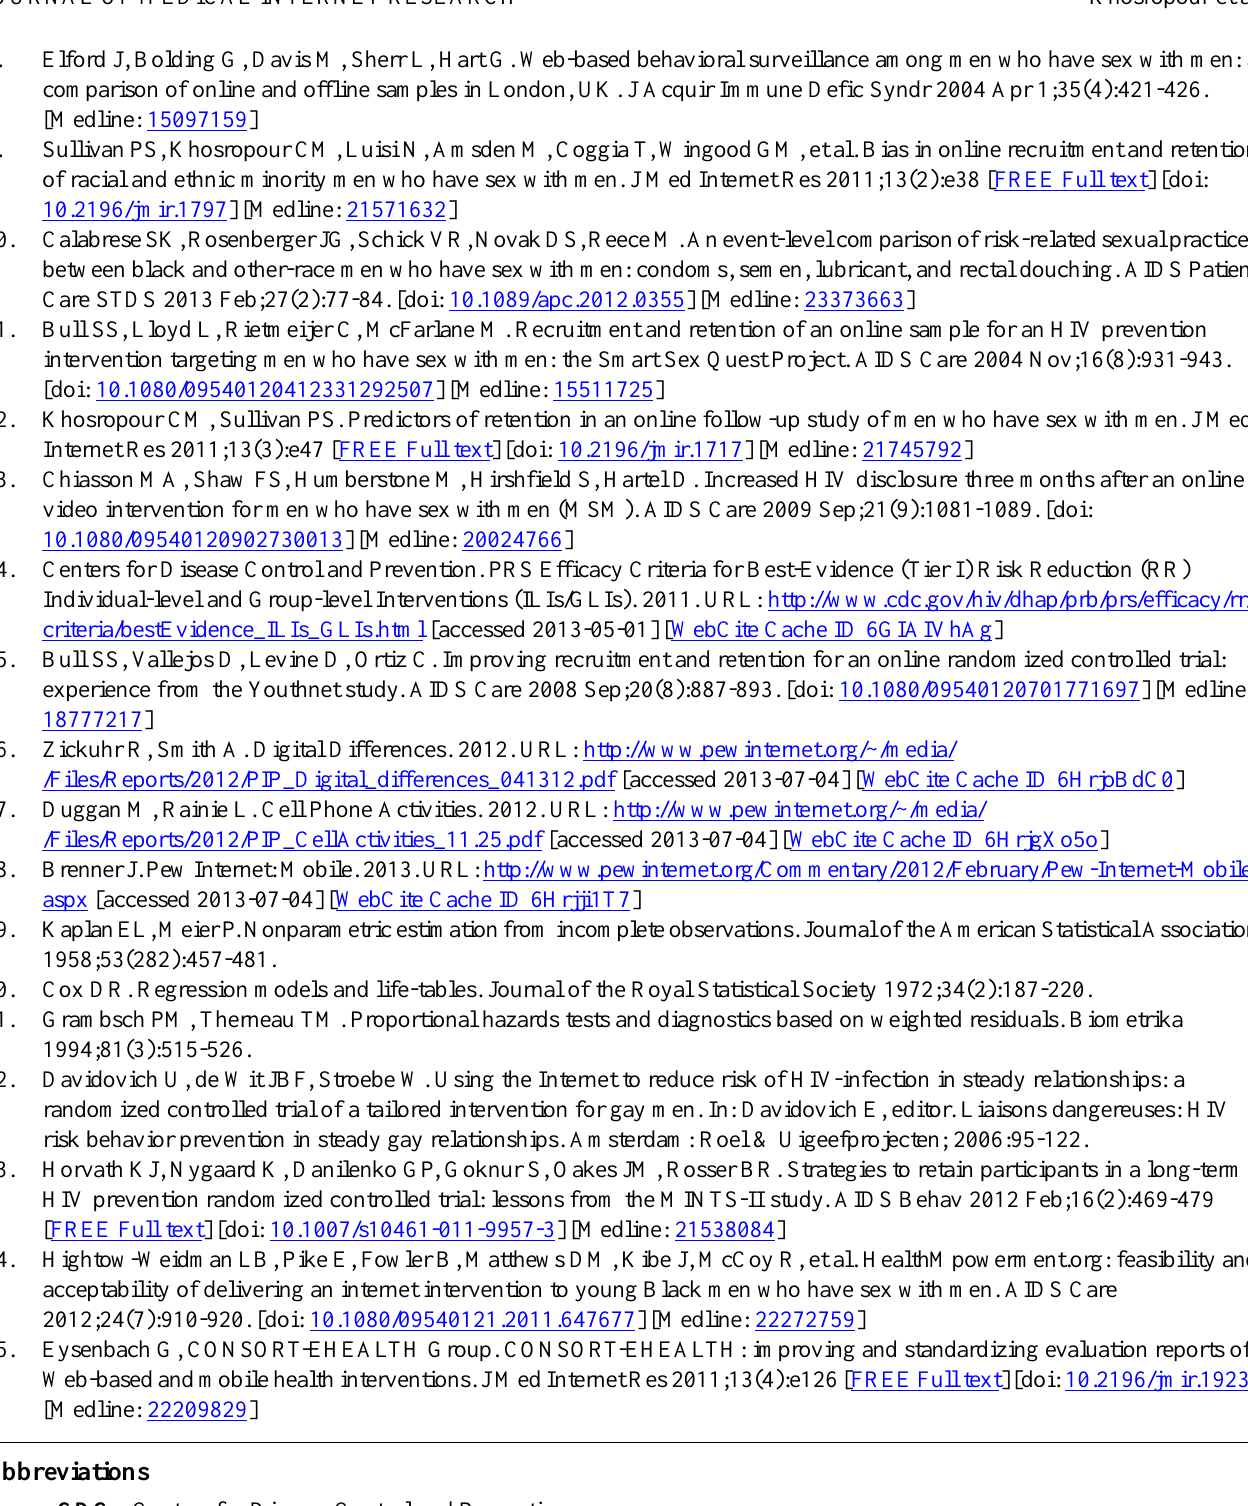
CDC: Centers for Disease Control and Prevention IRB: Institutional Review Board MSM: men who have sex with